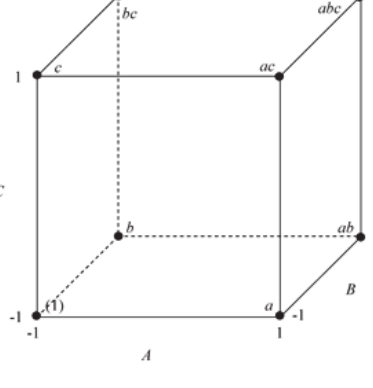
3 sample Figure 4. 2 3 sample points. Figure 4. 2